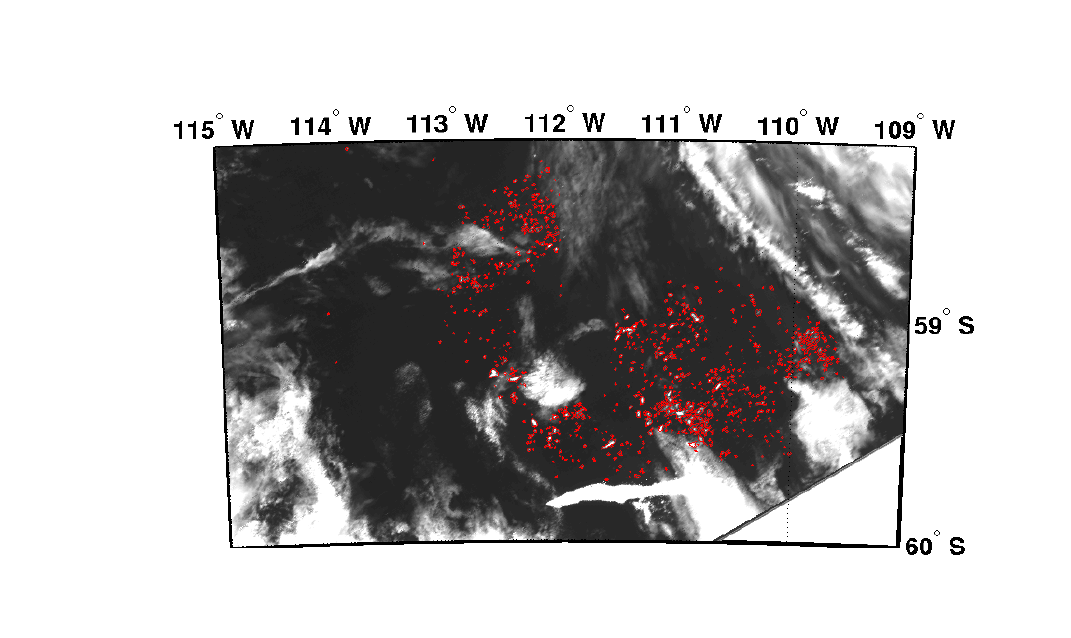
Figure 12. Example of fragment detection using a MODIS image (C19a 5 February 2009). The contour of the detected icebergs are repre- sented with red lines.